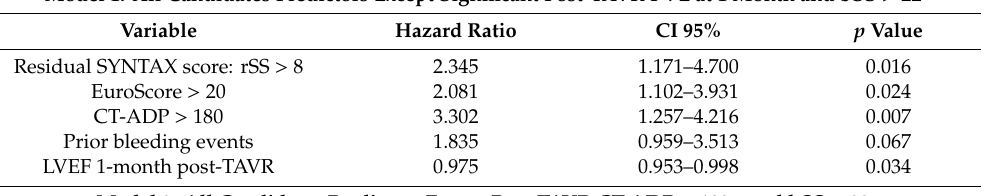
Table 6. Multivariate analysis of association between rSS with baseline characteristics and late major / life-threatening bleeding (MLBCs)